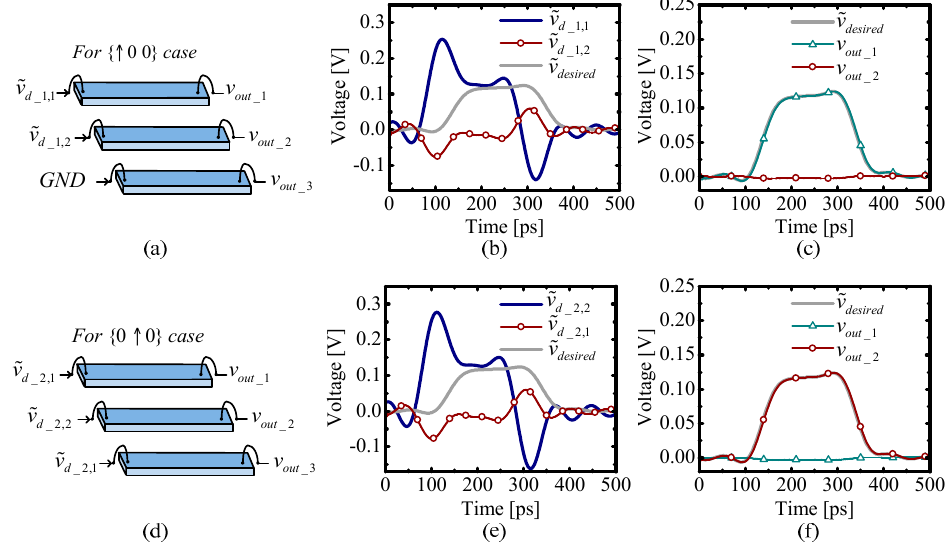
Figure 9. Design results for a multi-line equalizer. ( a ) and ( d ) are test benches for { ↑ 0 0} and {0 ↑ 0} cases, respectively. ( b ) and ( e ) are proposed waveforms using Algorithm 2. ( c ) and ( f ) are the SPICE verification for each test bench. Note that the frequency components exceeding 12.5 GHz were relaxed. Table 2. Summary of multi-line design results.